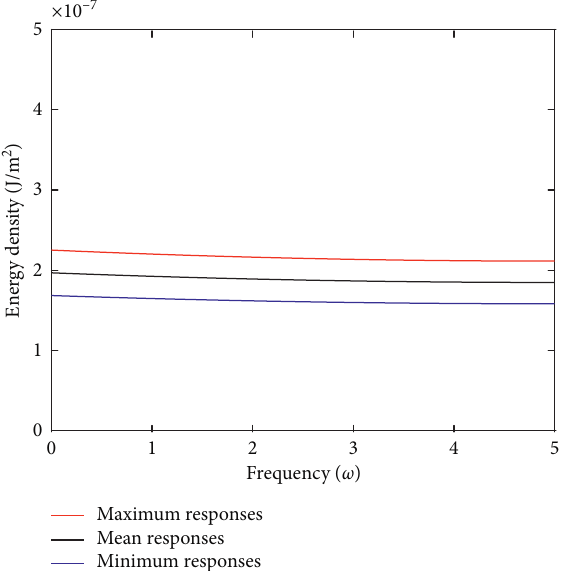
Figure 13: Energy density interval of the beam with a random-location excitation in space.